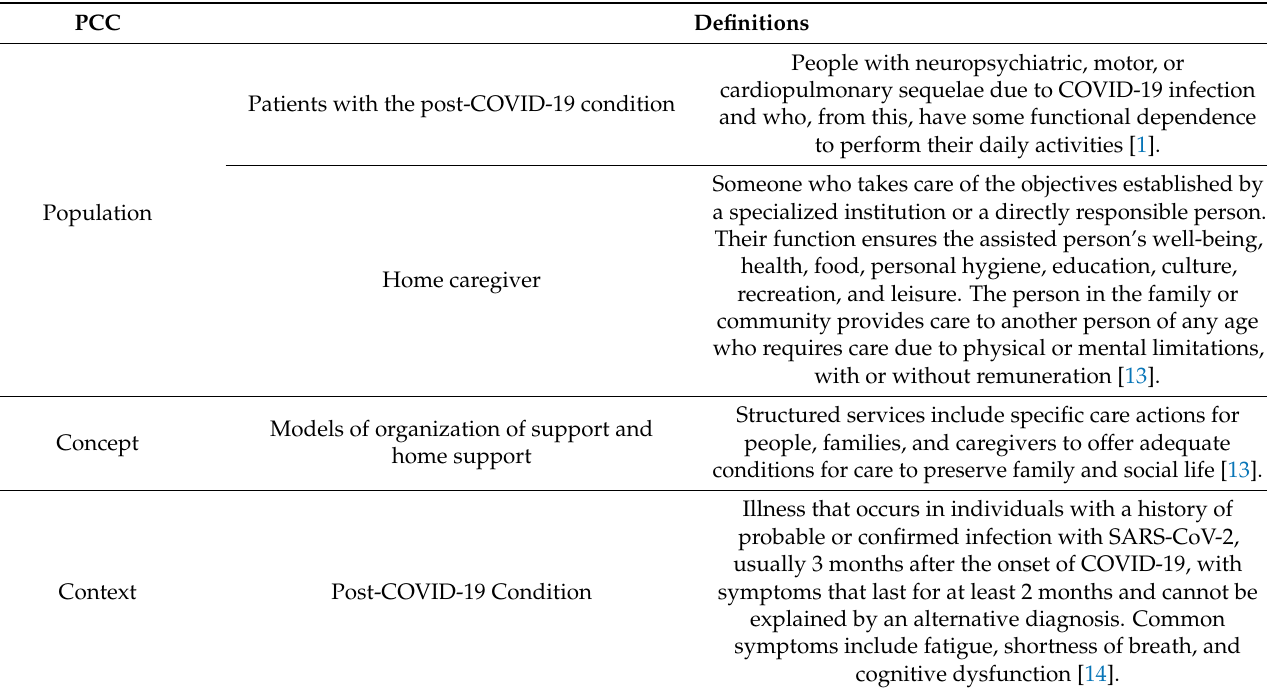
Table 1. PCC framework for defining the eligibility of the